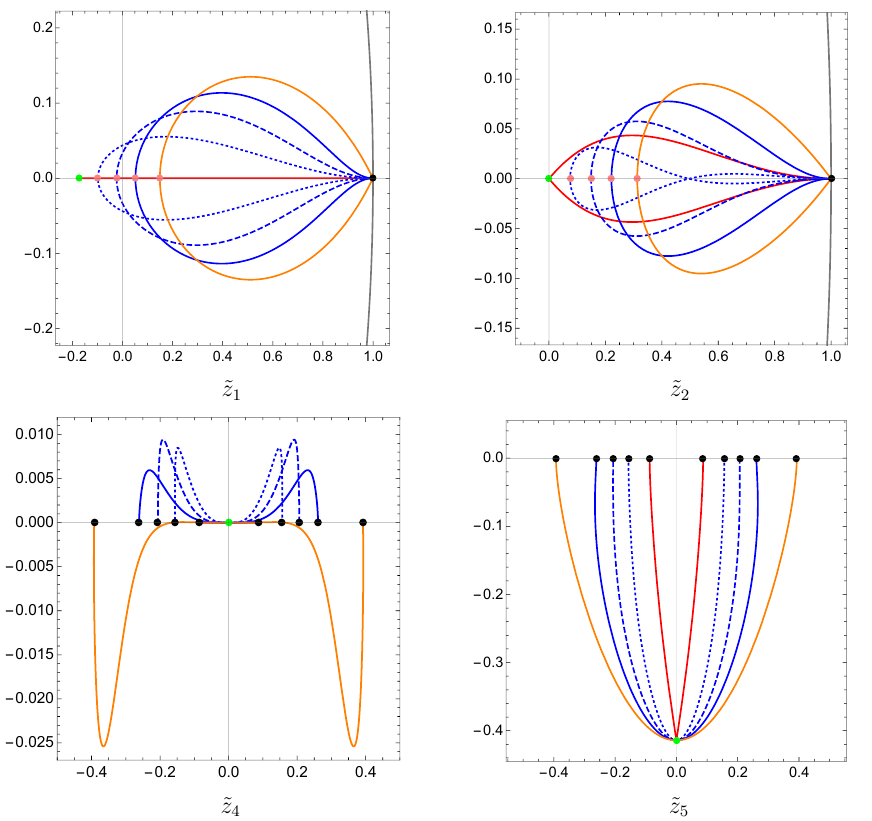
Figure 4 . Samples of regular flows within the SU(2) -invariant sector using the boundary con- ditions (3.30) for the complex scalar fields ˜ z (bottom-right). The N = 2 & U(2) AdS green and black dots, respectively. The grey lines in the left column plots correspond to the boundary values | ˜ z = 1 . The red flow corresponds to the choice (cid:15) ≈ 0 whereas the orange one corresponds 1 | to (cid:15) ≈ (cid:15) . Black dots in the bottom plots are compatible with SO(6) invariance, i.e. ˜ z crit real-valued, and correspond to the values ± Φ at r → ±∞